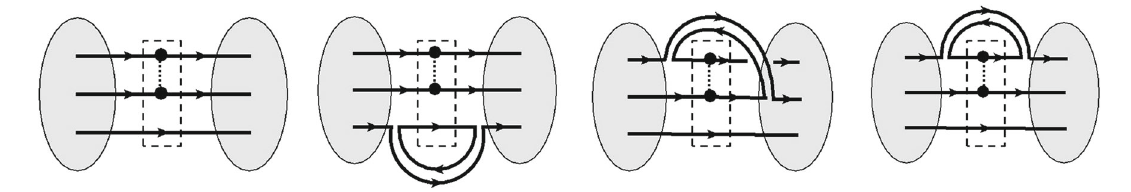
Fig. 3 Illustration of how a short-distance connected four quark interaction, represented by the interaction vertex in the dashed box, could induce (1) connected diagram (the second), (2) quark-loop diagram type D a (the third) and (3) quark-loop diagram type D b (the fourth) under long-range QCD